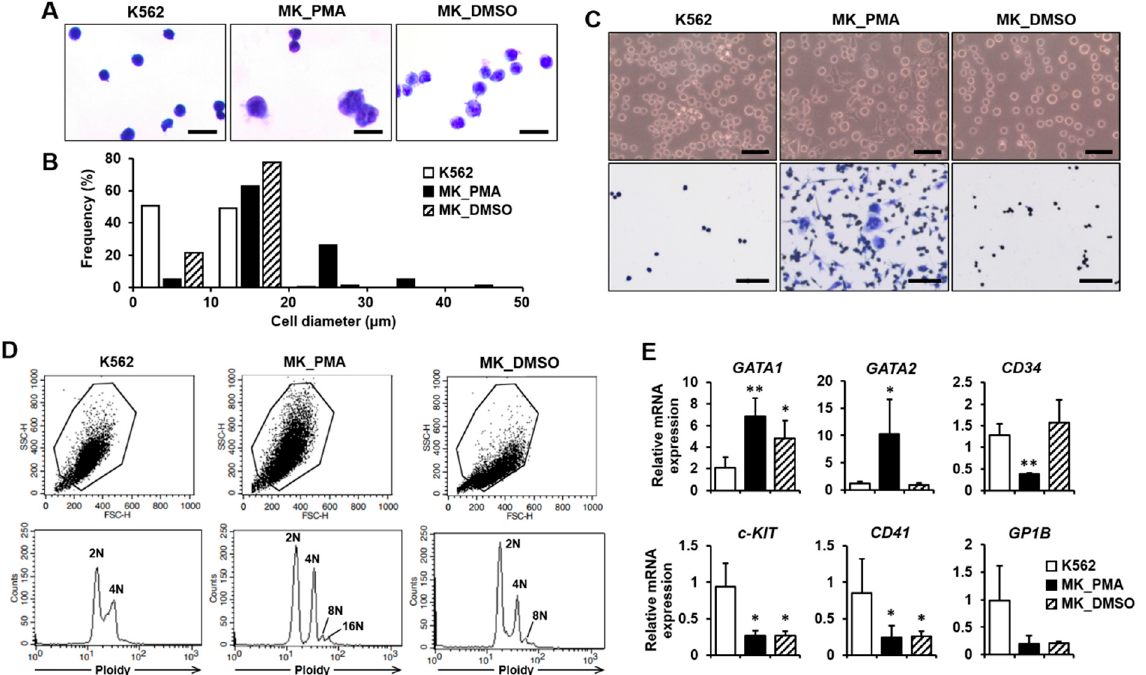
Figure 1. Verification of K562 cell differentiation into megakaryocytes. ( A , B ) The morphologies and diameters of K562 cells (K562s), PMA-induced megakaryocytes (MK_PMAs), and DMSO-treated megakaryocytes (MK_DMSOs) were comparatively analyzed through cytological staining ( A ) and size quantification ( B ). K562 cells were treated with PMA or DMSO for 7 days. Cell size was classified into 10 µ m increments ranging from 0 to 50 µ m in diameter. A total of 626 K562s, 401 MK_PMAs, and 464 MK_DMSOs were quantified by the percentage of frequency using the i-Solution image analysis program. Scale bar = 25 µ m. ( C ) Verification of K562 cell differentiation into megakaryocytes by cell adherence. Adhesive properties to the culture plate were verified before and after Hemacolor Rapid staining, as shown in the upper and lower panels, respectively. Scale bar = 100 µ m. ( D ) Representative data showing ploidy of megakaryocytes after 7 days of differentiation with PMA. MK_PMAs were compared with K562s or MK_DMSOs. ( E ) mRNA levels of GATA1 , GATA2 , CD34 , c-KIT , CD41 , and GP1B were evaluated using qPCR in MK_PMAs or MK_DMSOs and compared with those in K562 cells. The relative mRNA expression level was plotted against gene expression level for K562 cells. The results are presented as the mean ± standard deviation of three independent experiments. *, p < 0.05; **, p < 0.01 versus K562 cells.